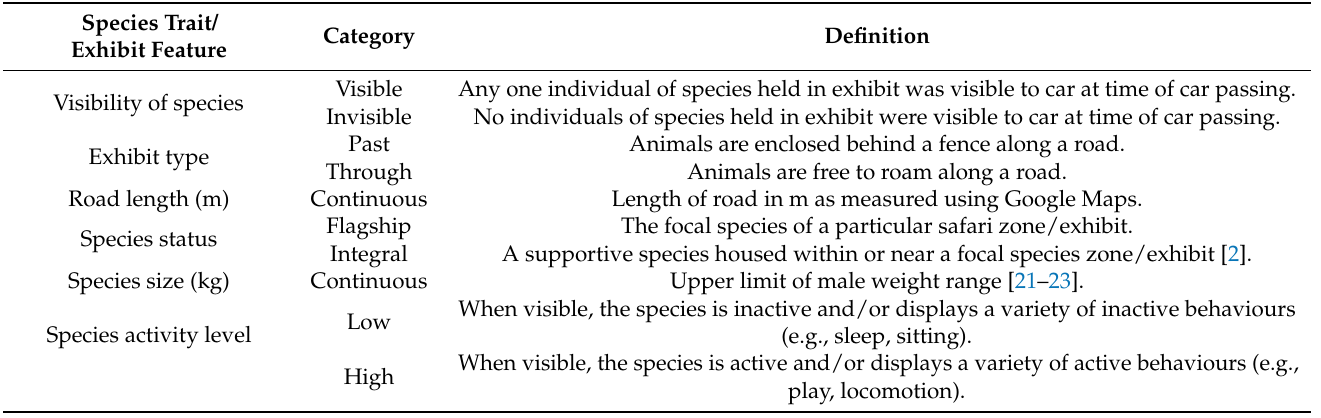
Table 1. Definitions of species traits and exhibit features explored in